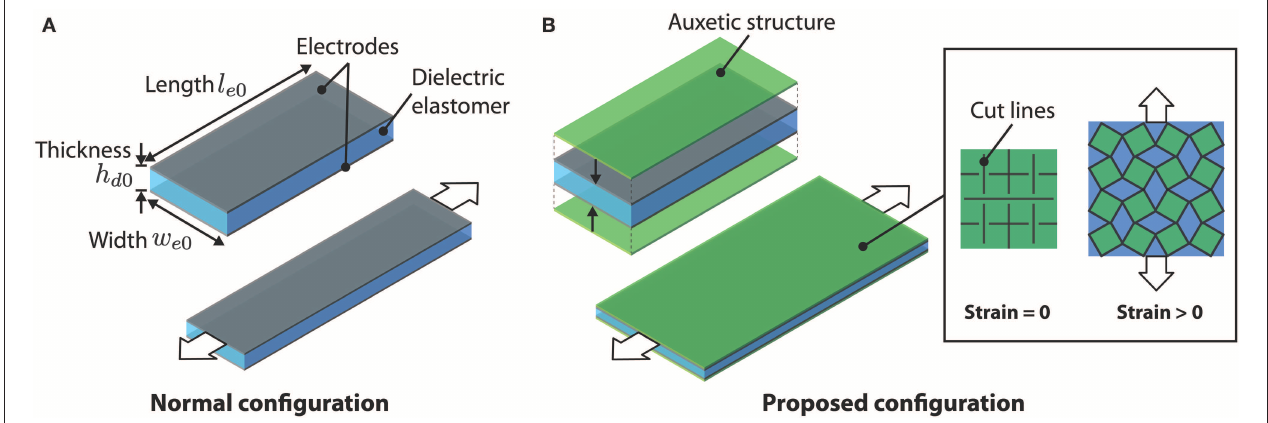
FIGURE 1 | (A) Schematics of capacitive-type stretchable strain sensor. (B) Schematics of the senor with the hierarchical auxetic structure proposed in this